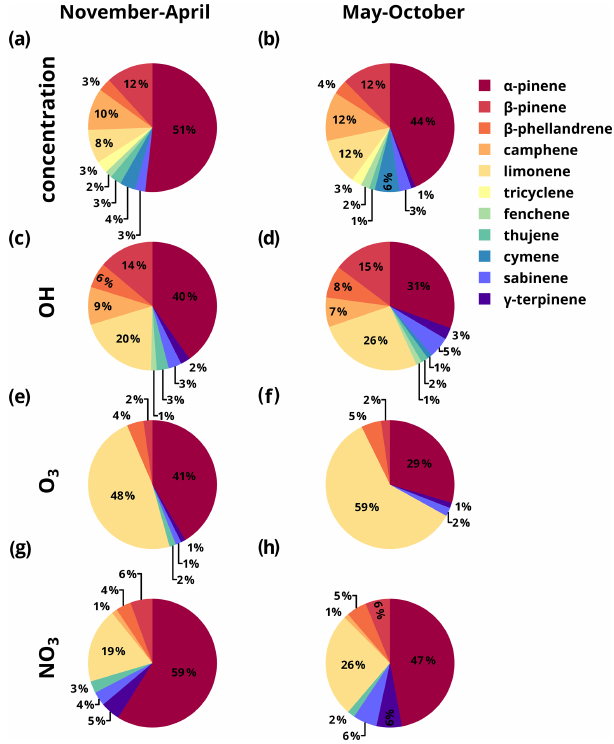
Figure 8. A breakdown of detected monoterpene isomers in the growing and non-growing seasons for (a–b) concentration, (c–d) OH reactivity, (e–f) ozone reactivity, and (g–h) nitrate reactivity. Values are rounded to the nearest percent, and values below 1% are not